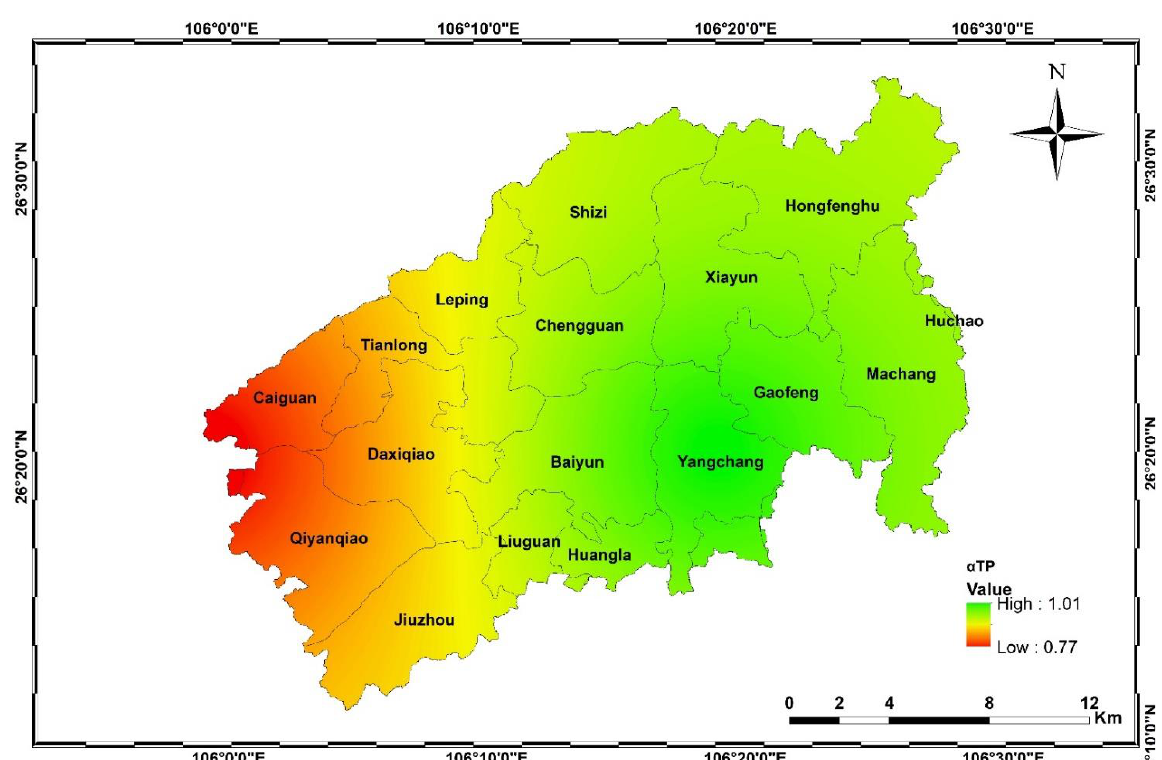
Figure 3. Spatial distribution of major parameters of PTRE – NPS of TN in the Hongfenghu reservoir watershed.